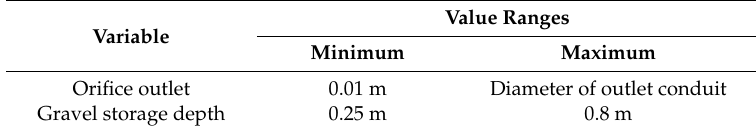
Table A1. Value ranges for the optimisation of the orifice outlet and gravel storage depth.